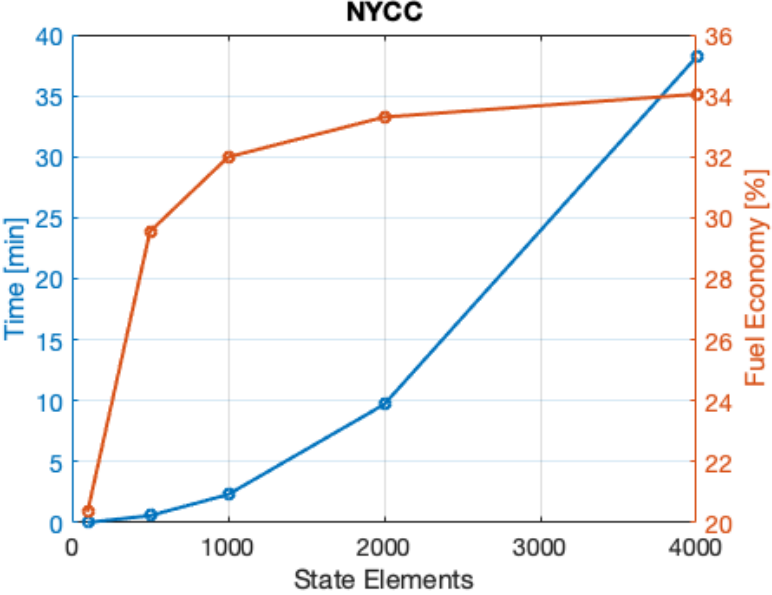
Figure 8. Influence of the number of the discrete state elements on the computational and fuel economy achieved through IFADP on the NYCC driving cycle.